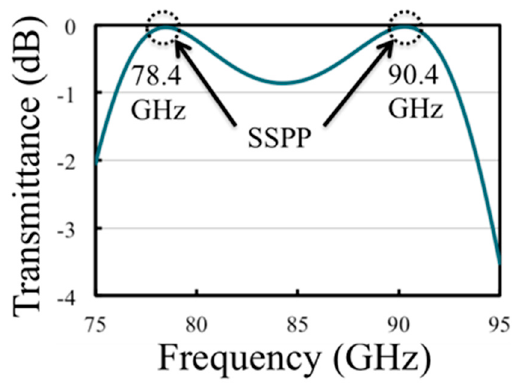
Figure 7. The frequency dependence of the transmittance of the MHA.